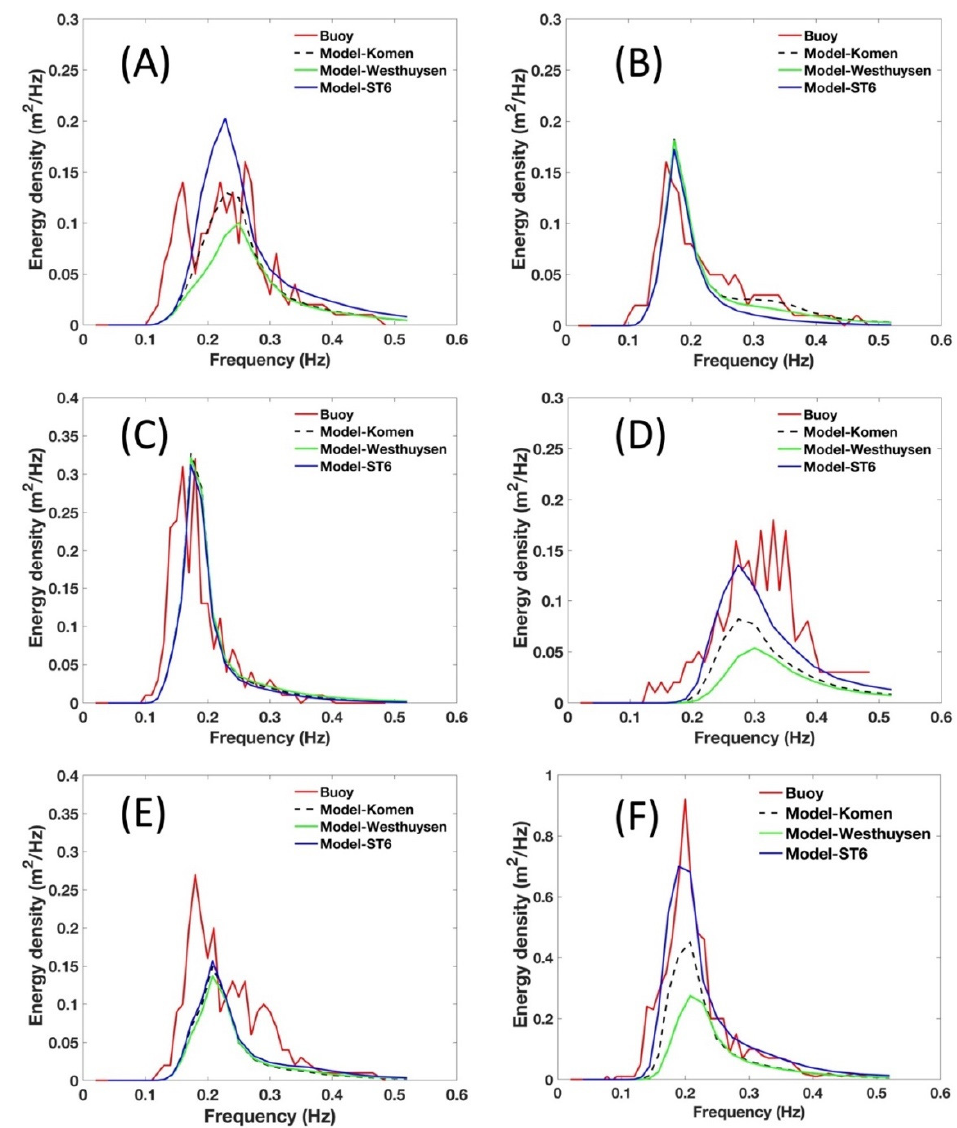
Figure 11. Wave spectrum on ( A ) 3 July 2015; ( B ) 10 July 2015; ( C ) 11 July 2015; ( D ) 23 July 2015; ( E ) 4 August 2015 ( t 1 ), and ( F ) 17 August 2015 ( t 2 ).